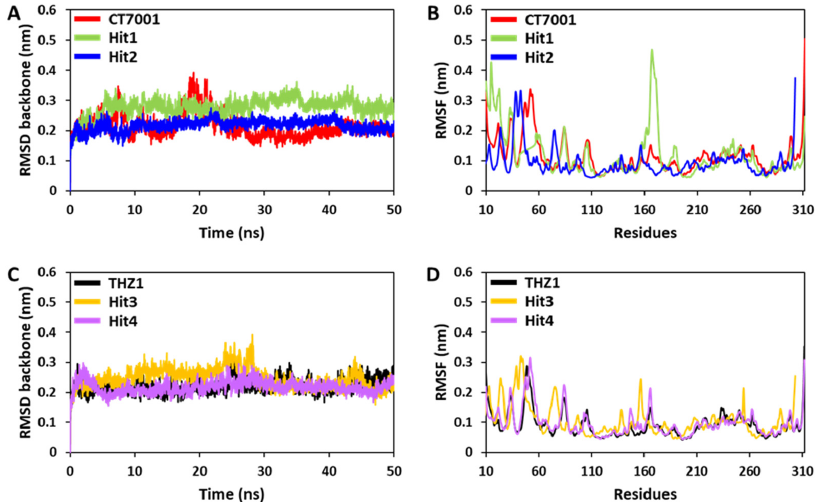
Figure 6. MD simulation analyses display the backbone RMSD and RMSF for ( A , B ) CT7001, Hit1, and Hit2, respectively, and ( C , D ) THZ1, Hit3, and